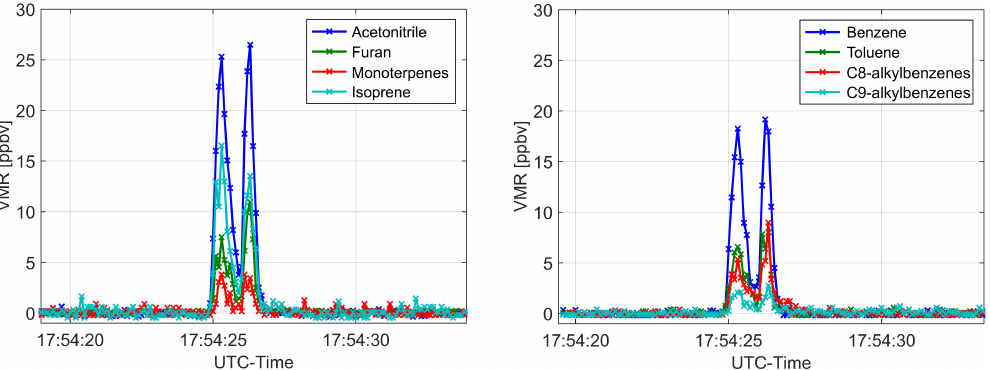
Figure 3. 10Hz time series of (a) acetonitrile, furan, the sum of monoterpene isomers, and isoprene and (b) benzene, toluene, C 8 - alkylbenzene isomers, and C 9 -alkylbenzene isomers as measured during the fourth fire overflight at 17:54:25UTC.